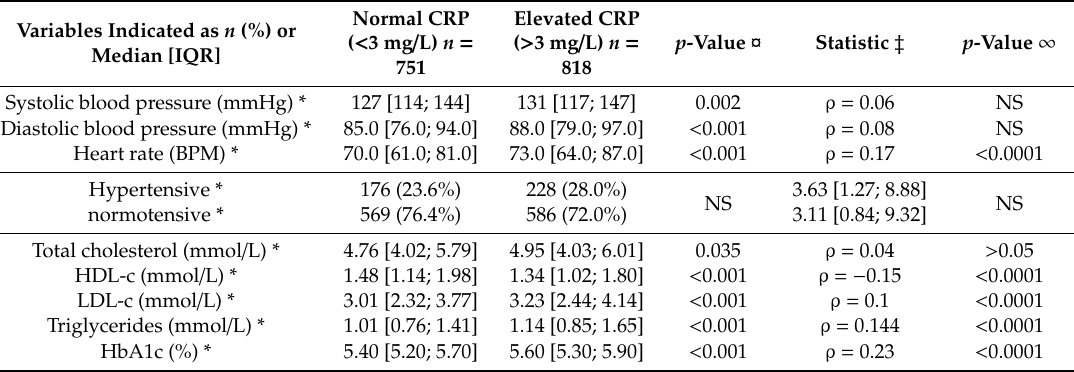
Table 3. Physiological and biochemical markers of increased CVD risk.